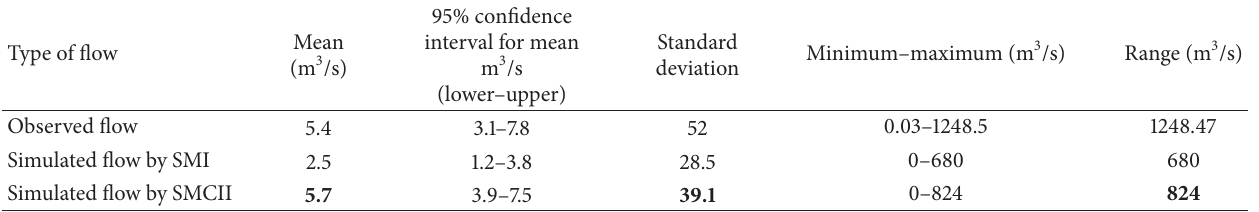
Table 6: General statistics of observed and simulated stream flow by using SMI and SMCII methods during model validation